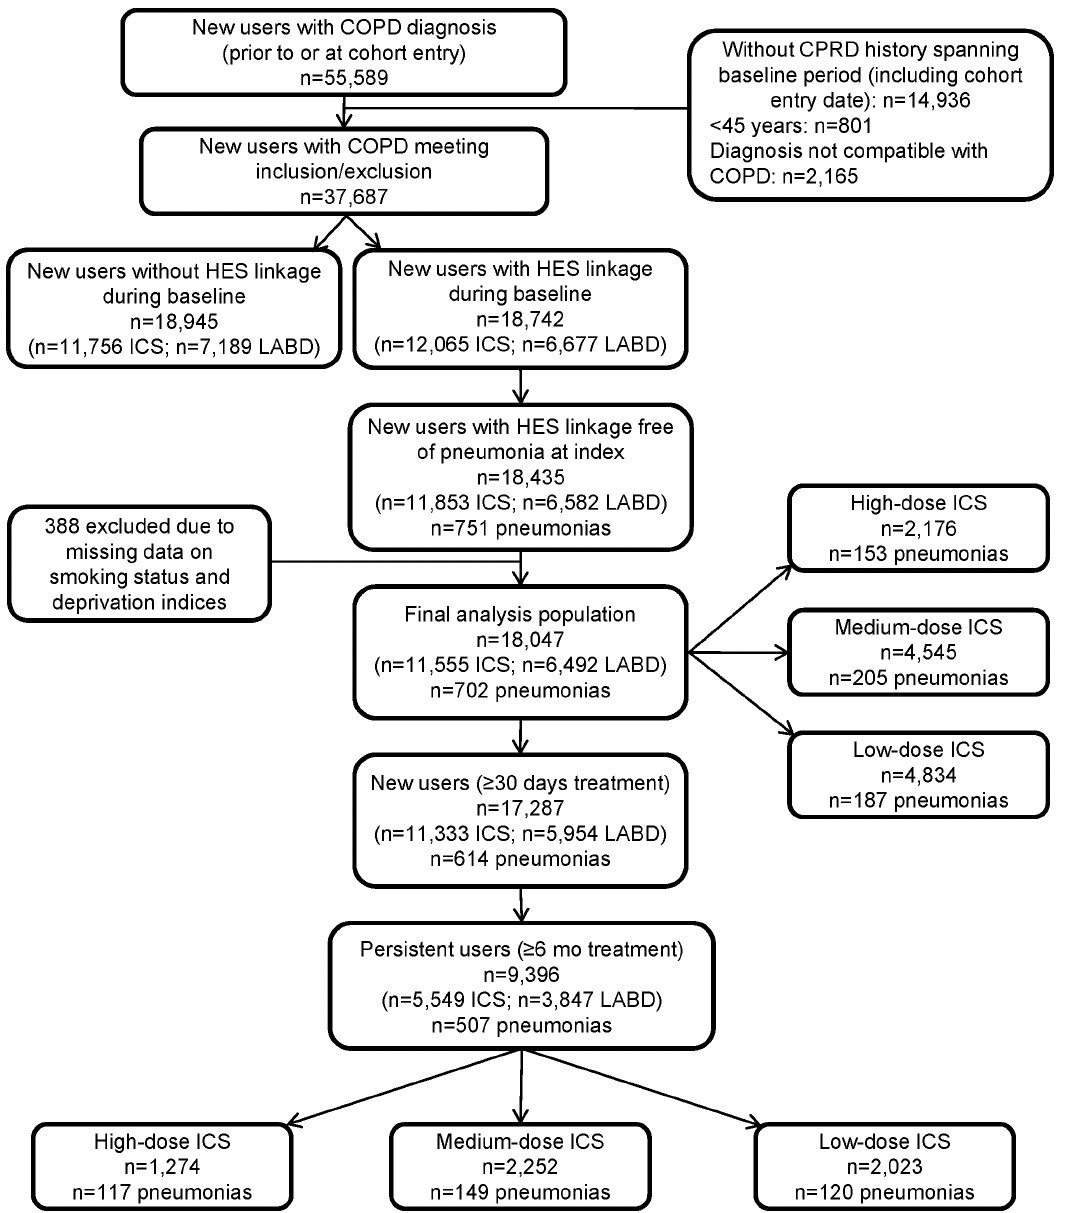
Figure 1. Patient record selection. n=10,338,432 research-quality patients in CPRD-COPD; n=645,287 new users of ICS-containing or new users of LABD medications COPD: chronic obstructive pulmonary disease; HES: Hospital Episode Statistics; ICS: inhaled corticosteroid; LABD: long-acting bronchodilator.